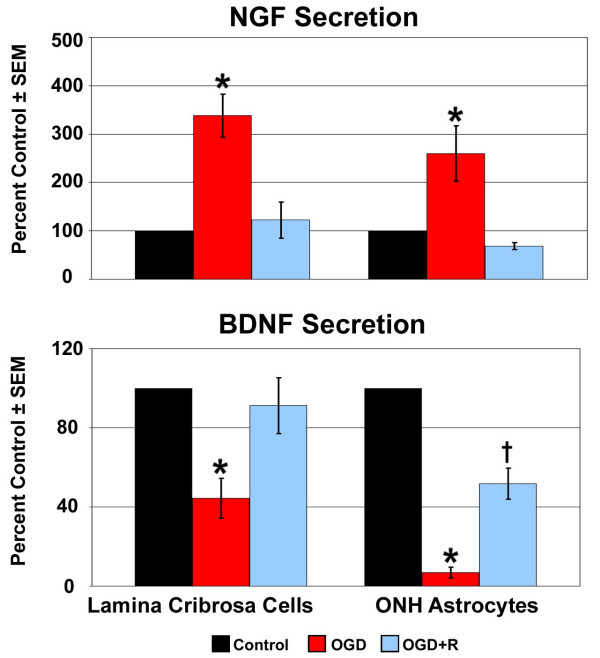
NT secretion following exposure to and recovery from Oxygen-Glucose Deprivation. Lamina cribrosa cells and ONH astrocytes were exposed to OGD for 48 hours (OGD) or to 48 hours OGD followed by recovery for 24 hours (OGD+R). NGF and BDNF secretion was determined by immunoassay of concentrated conditioned media from three LC cell lines and three ONH astrocyte cell lines. A NT standard was included in each assay and was used to generate a standard curve. Data are reported as percent of the control ± SEM (n = 3). * indicates p < 0.016 for OGD compared to C and OGD+R; † indicates p < 0.016 for OGD+R compared to C (one way analysis of variance [ANOVA] followed by validation using Student-Newman-Keuls tests).